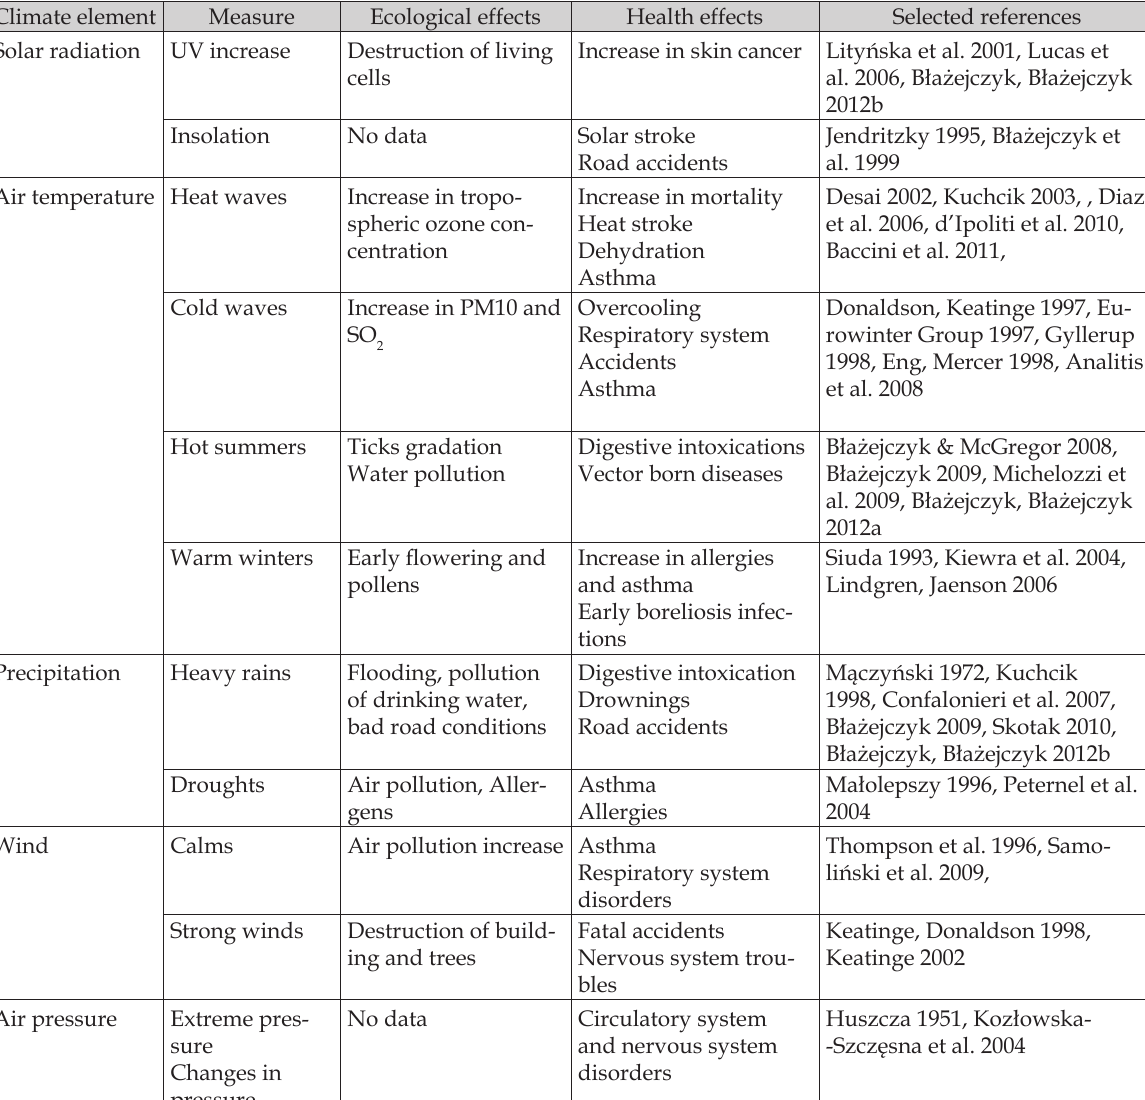
Table 1. Ecological and health effects of climate